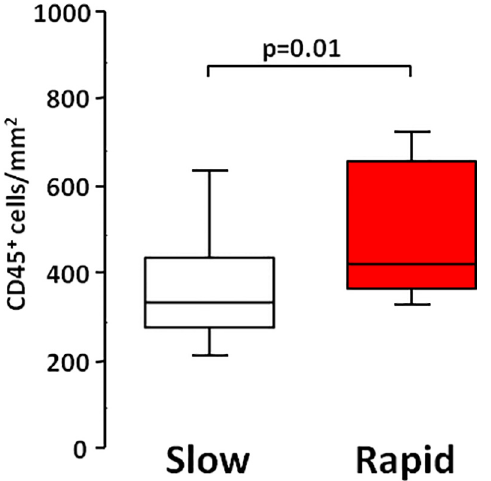
Fig 2. Total inflammatory cells in slow and rapid progressors. Number of total leukocytes (CD45 + /mm 2 ) in the lungs of slow and rapid progressors. Horizontal bars represent median values; bottom and top of each box plot 25 th and 75 th , brackets 10 th and 90 th percentiles. Slow: white; rapid: